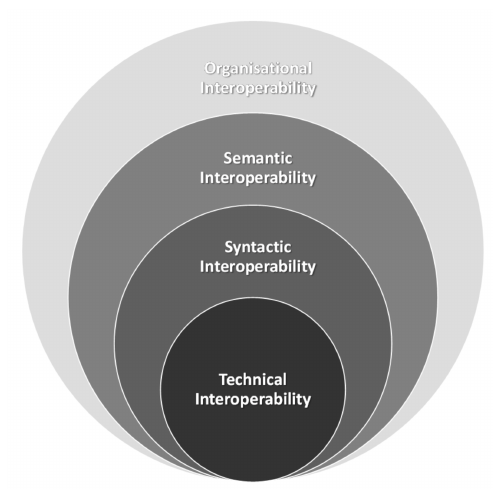
Figure 2. The dimensions of interoperability [3]. Table 1. IoT layers, interoperability points and indicative